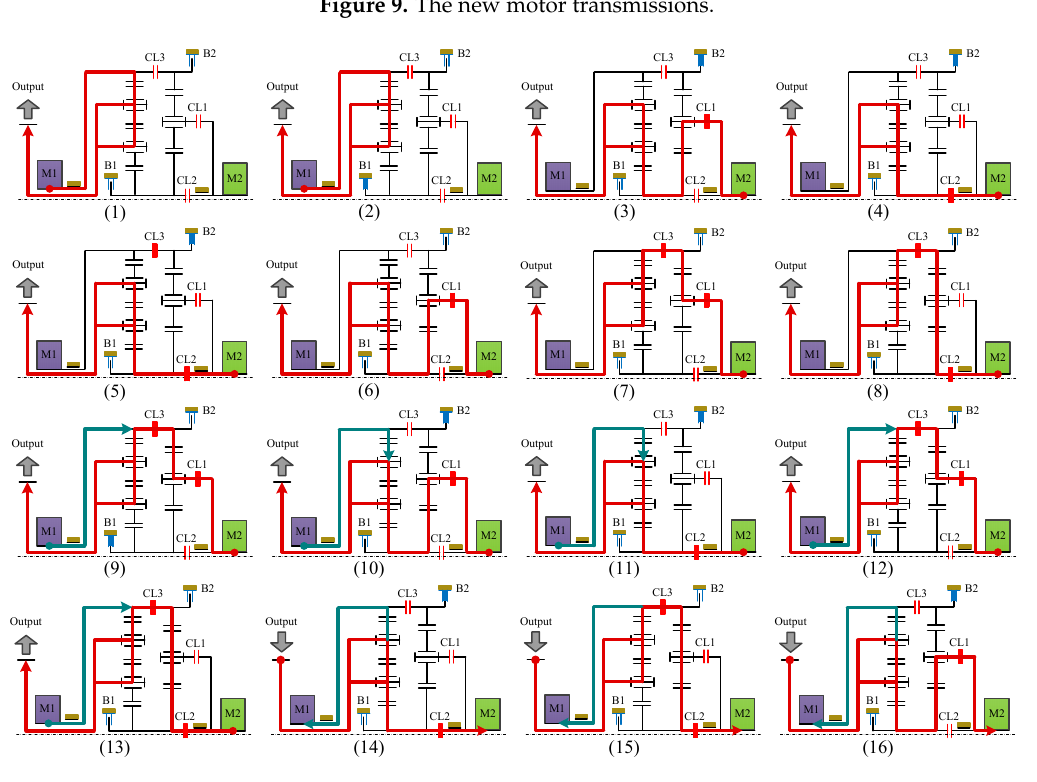
Figure 10. Operation modes for the No. 6 motor transmission. Table 1. Operation modes and clutching conditions.